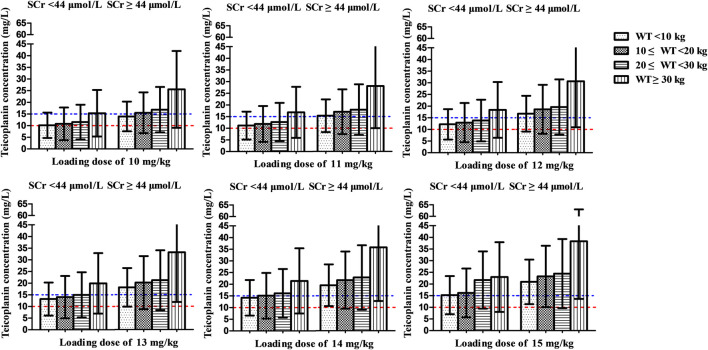
Mean teicoplanin Cmin with different loading doses in subgroups stratified by weight (WT, kg) and serum creatinine (SCr, μmol/L). Each bar represents the mean ± standard deviation. Loading doses were administered every 12 h for three doses and C
min was simulated by day 3 (48 h). The dashed red line and blue line indicate the target C
min of 10 mg/L (moderate infection) and 15 mg/L (severe infection), respectively.